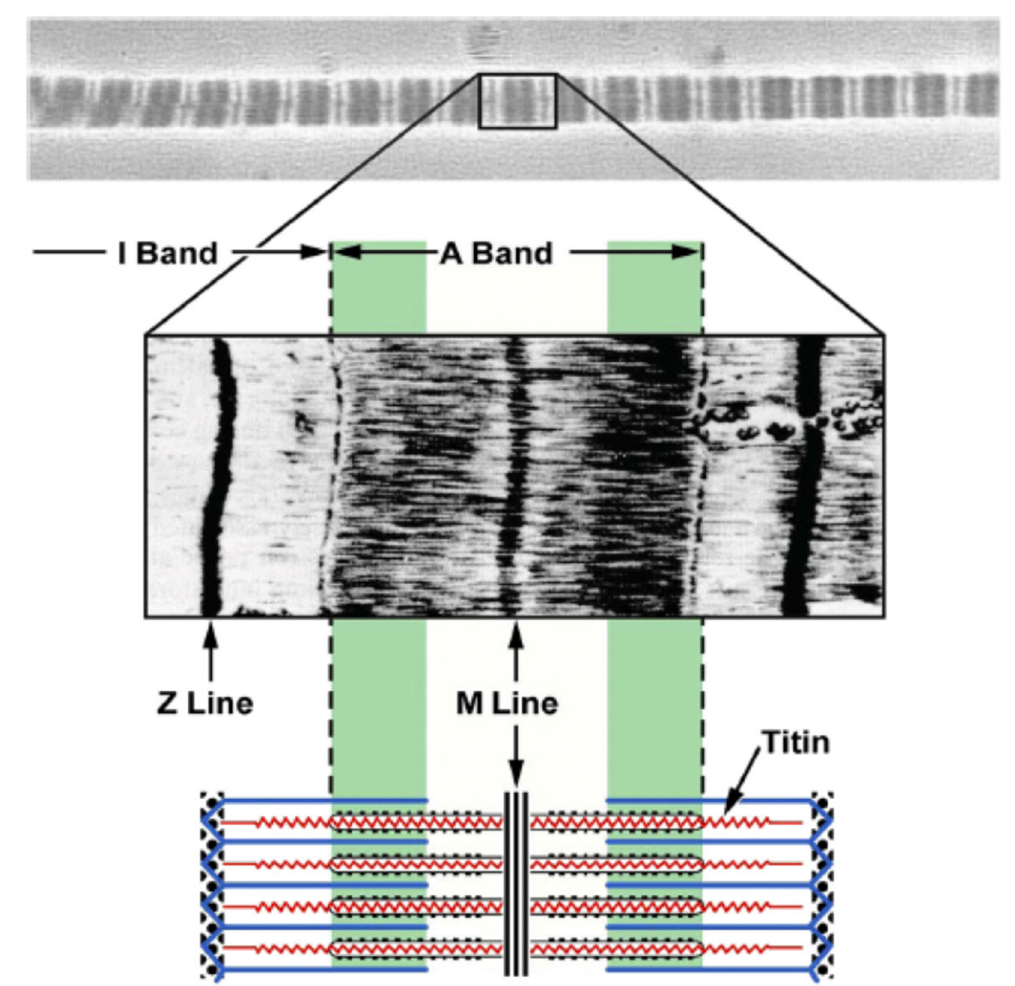
Figure 6. The location of titin in the sarcomere [46]. Titin spans from the Z line to M line. Titin in the A band region is strongly connected with the myosin filament so that this region cannot be elongated during stretch. In contrast, titin in the I band region acts like a molecular spring and accommodates elongations of sarcomeres (Reprinted with permission).